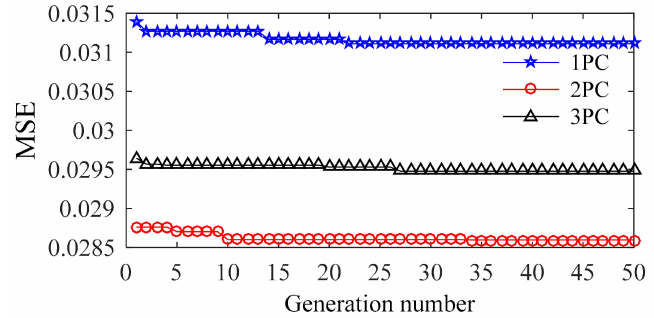
Figure 10. MSE values determined by